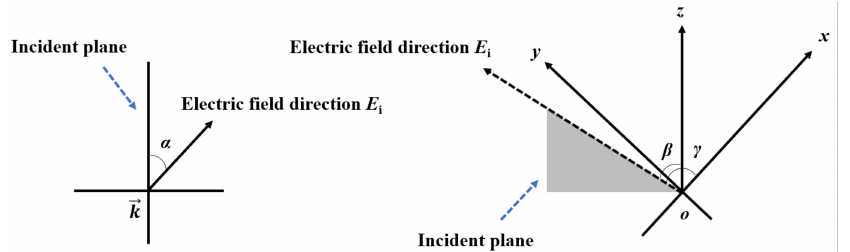
Figure 1. Illustration of incident angle and polarization